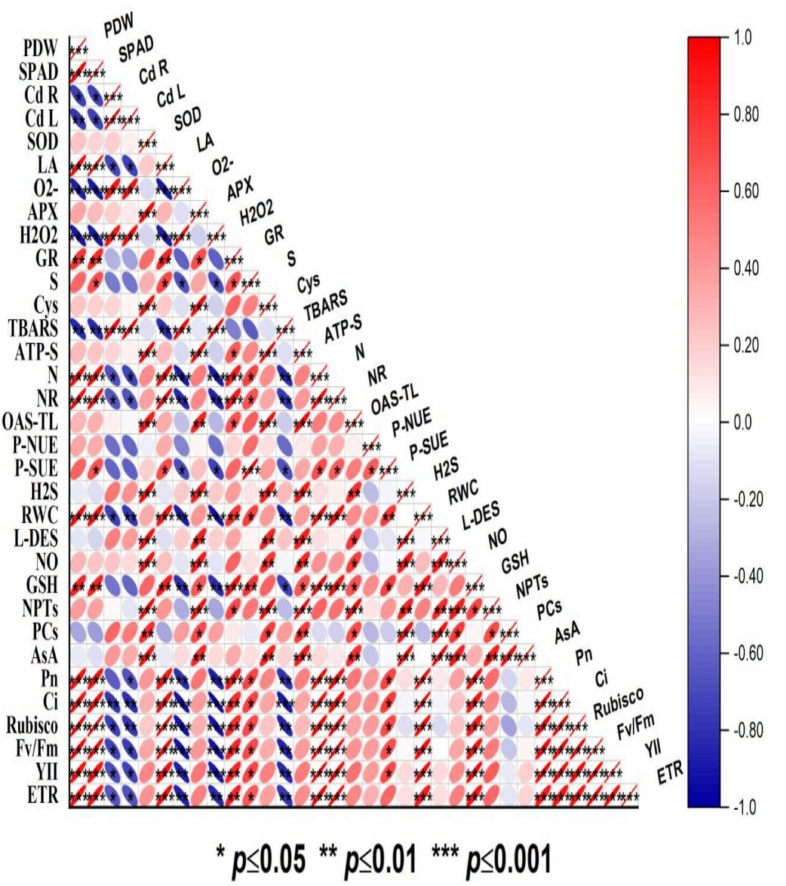
Figure 6. Pearson correlation matrix represents correlations at p ≤ 0.05, p ≤ 0.01, and p ≤ 0.001 between different growth, photosynthesis, oxidative stress, antioxidant metabolism, and S and N metabolism parameters in mustard ( Brassica juncea L. cv. Giriraj) treated with 100 µ M SNP (NO donor) and 200 mg S kg − 1 soil of elemental sulfur (ES) or ammonium sulfate (AS) in the presence or absence of 200 mg Cd kg − 1 . Scale represents Pearson correlation (r) values that range from − 1 to +1. Net photosynthesis (P N ), intercellular CO 2 concentration (Cint), Rubisco activity, reduced glutathione (GSH), ATP-sulfurylase (ATP-S), O-acetylserine (thiol) lyase (OAS-TL) nitrate reductase (NR), fresh weight (FW), dry weight (DW), glutathione reductase (GR), non-protein thiols (NPT), nitric oxide (NO), H 2 S, hydrogen sulfide; L-DES, L-cysteine dedulfhydrase; ascorbate (AsA), dehydroasorbate reductase (DHAR), superoxide dismutase (SOD), ascorbate peroxidase (APX), phytochelatins (PCs), cadmium root (Cd R), cadmium leaf (Cd L), H 2 O 2 content, electrolyte leakage (EL),